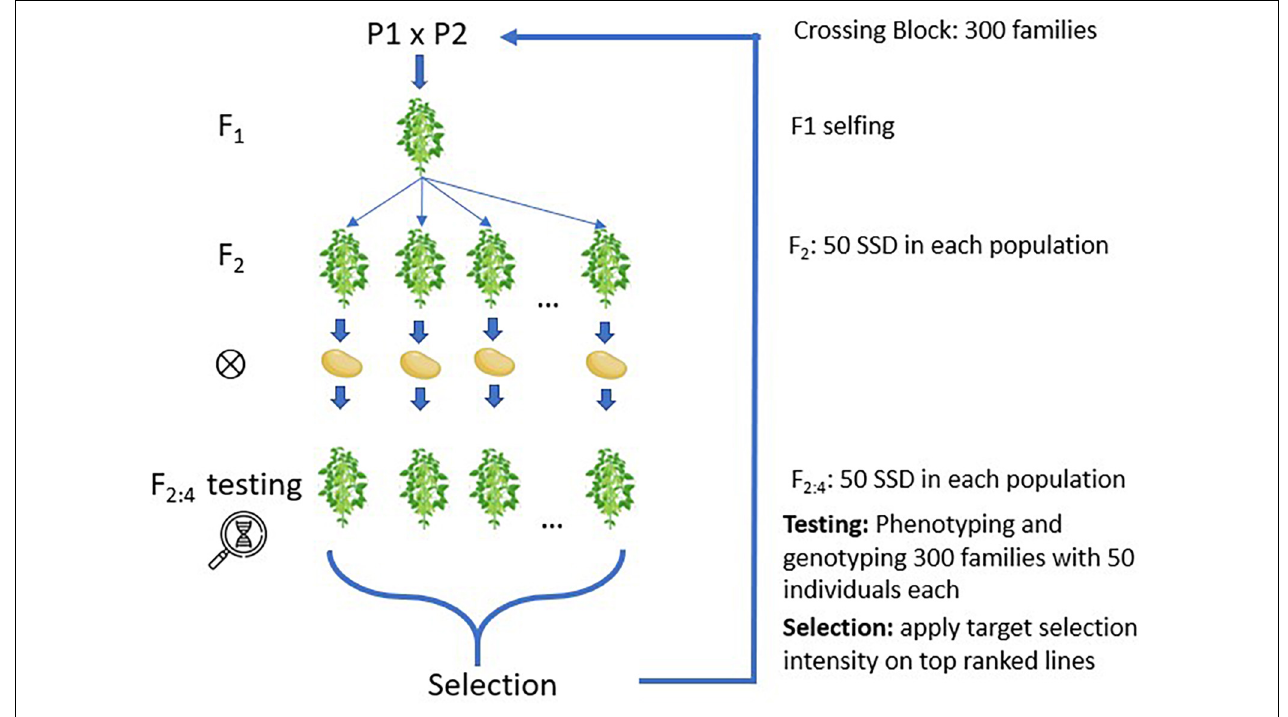
FIGURE 1 | Simulated families created and inbreeding using single seed descent